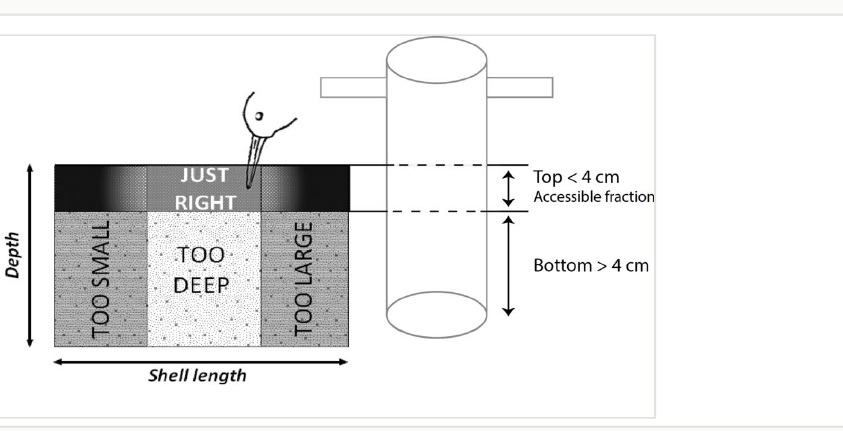
Sampling site with the 259 regular station, across four study sites, in the Pertuis Charentais, on the French Atlantic coast.